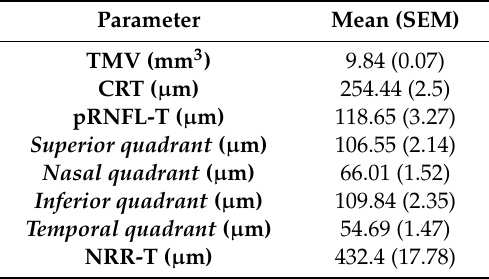
Table 2. Optical coherence tomography (OCT) parameters in RR-MS patients at baseline.